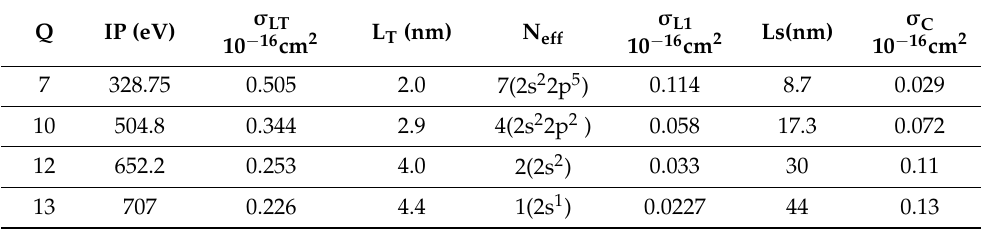
Figure 1. Mean-charge evolution of S (2 MeV/u) ions along the depth in carbon foils for the incident charge Q o =7 and equilibrium charge (Q eq =12.68) [60]: Sum of two saturation-curves approximation (Equation (2b)) (o) and single saturation-curve fit (Equation (2a)) (+) to the experimental mean-charge evolution (●). L is the characteristic length for attaining the equilibrium charge. Table 2. Total electron loss cross section ( σ LT ) after [62], single electron loss cross section ( σ L1 ) after [63,64] and single electron capture cross section from [68] in 10 − 16 cm 2 for 2 MeV/u 32 S with charge state Q relevant to this study. IP is the first ionization potential for S +Q state [65] and N eff is the number of removable electrons. L is the characteristic length for attaining the equilibrium charge (L T = 1/ σ LT N, L S = 1/ σ L1 N) corresponding to the total and single electron loss, N = 10 23 cm − 3 (carbon density, 2 g cm − 3 ). The electronic configuration contributing to N eff for the S projectile ions at a given charge state is denoted in the parenthesis. The projectile velocity (V p ) divided by V o is 8.94 and the kinetic energy of the electron with V p is 1088